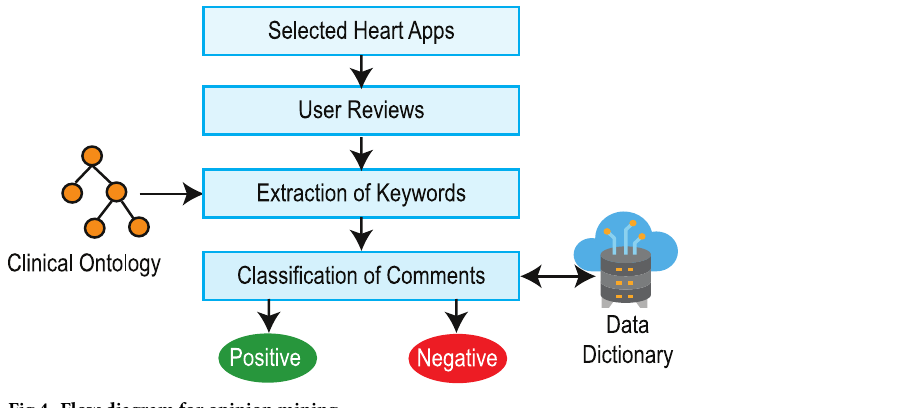
Fig 4. Flow diagram for opinion